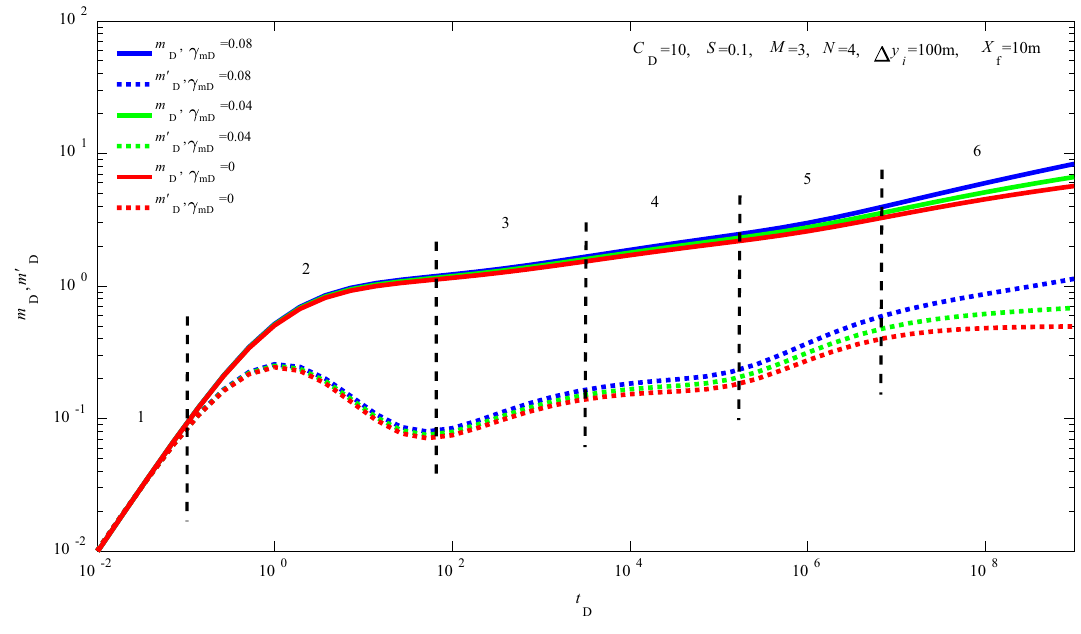
Fig. 4 Effect of permeability modulus on transient pressure